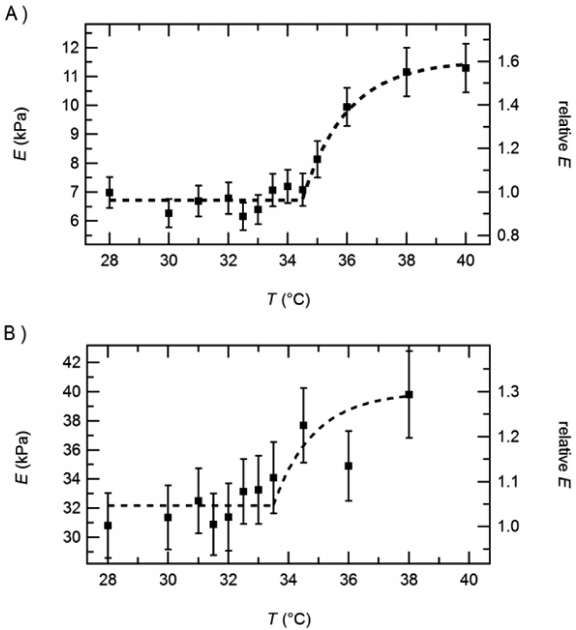
Figure 9. Temperature-dependent elastic moduli of PNIPAM- PAAM core-shell particles with thin ( A ) and thick ( B ) PAAM shell. Taken from